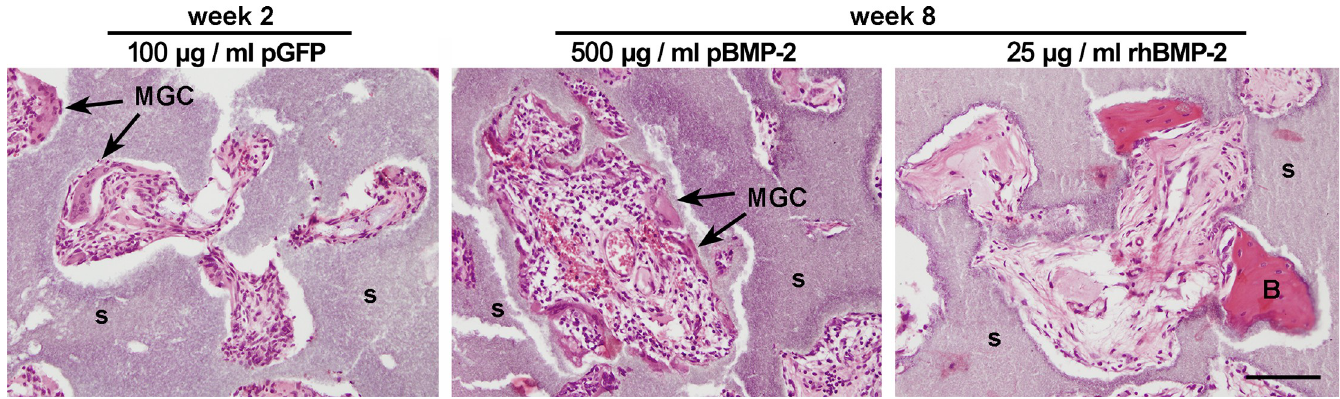
Fig 2. Tissue ingrowth and bone formation after two and eight weeks in vivo. The images show H&E-stained sections of i.m. samples, containing 100 μ g/ml pGFP (week 2), 500 μ g/ml pBMP-2 or 25 μ g/ml rhBMP-2 (week 8) without seeded cells. A representative image of each group is shown. After two weeks, complete ingrowth of tissue could be observed as well as frequent presence of multinucleated giant cells (MGC). After eight weeks, alginate was no longer detectable in any of the constructs. In all groups containing pDNA a high cell density could be seen together with the frequent presence of MGCs. s = scaffold; B = bone; MGC = multinucleated giant cell. Scale bar = 100 μ